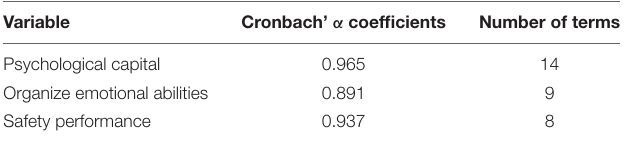
TABLE 3 | The reliability of variables.